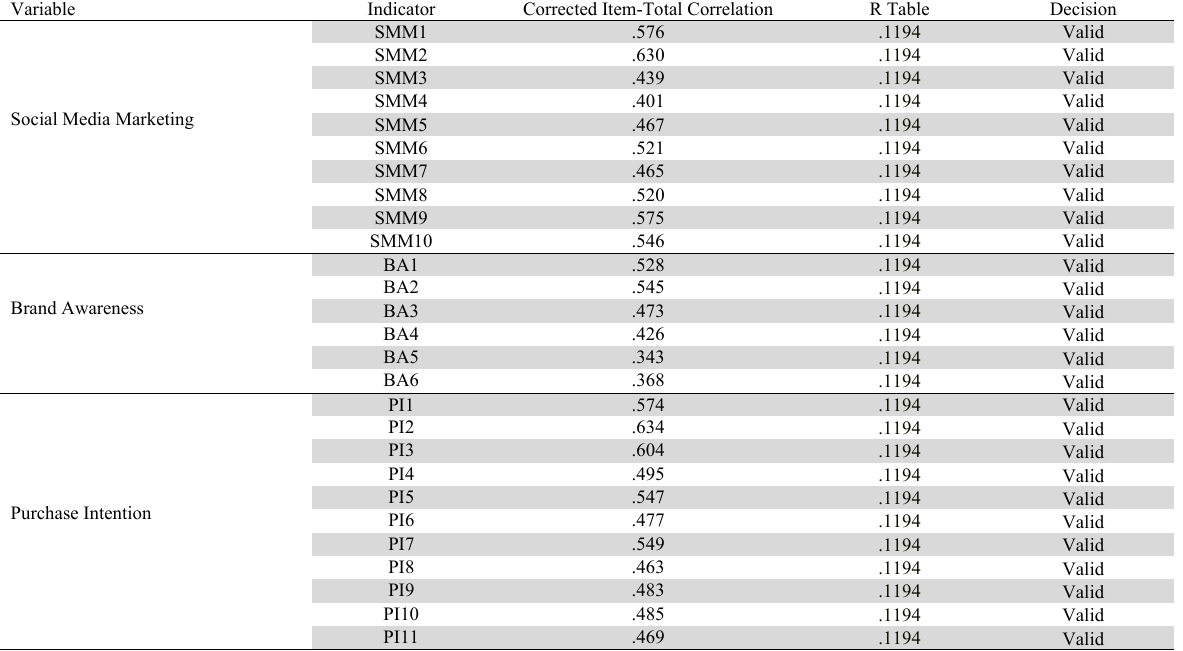
Result of Validity Test